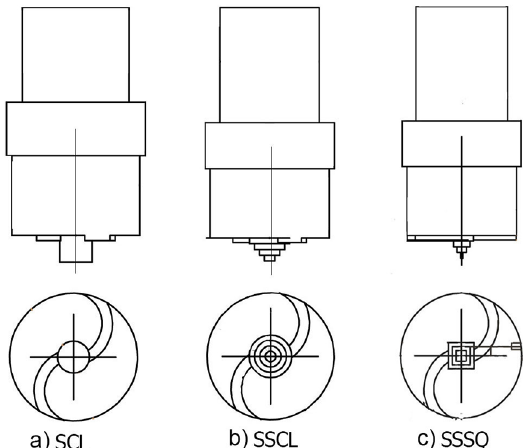
Figure 1. Different types of scroll shoulder, stepped tool pin profiles Scrolled Cylindrical (SCL), Scrolled Stepped Cylindrical (SSCL), and Scrolled Stepped Square